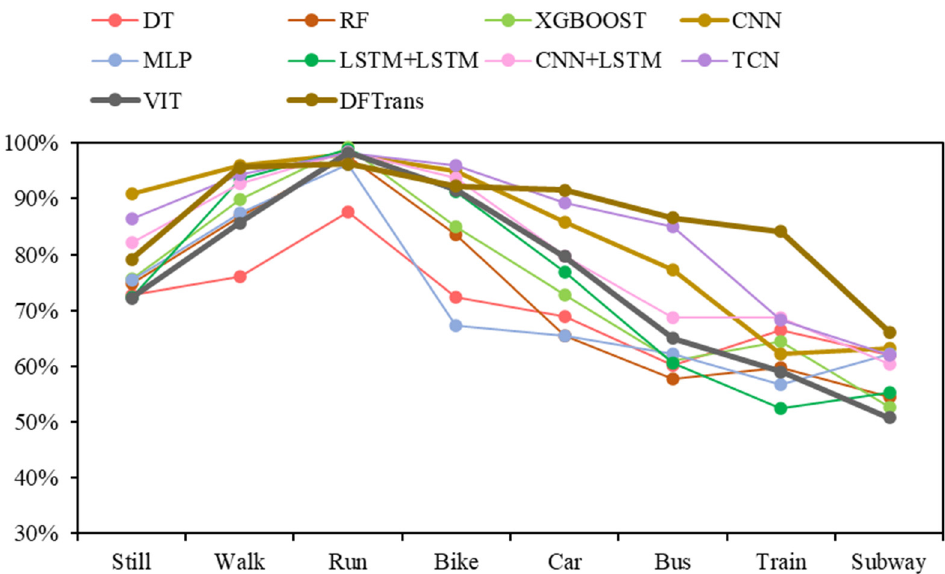
Figure 9. Variation in the performance of nine baselines and the DFTrans algorithm on eight trans- portation mode detection on the SHL dataset.